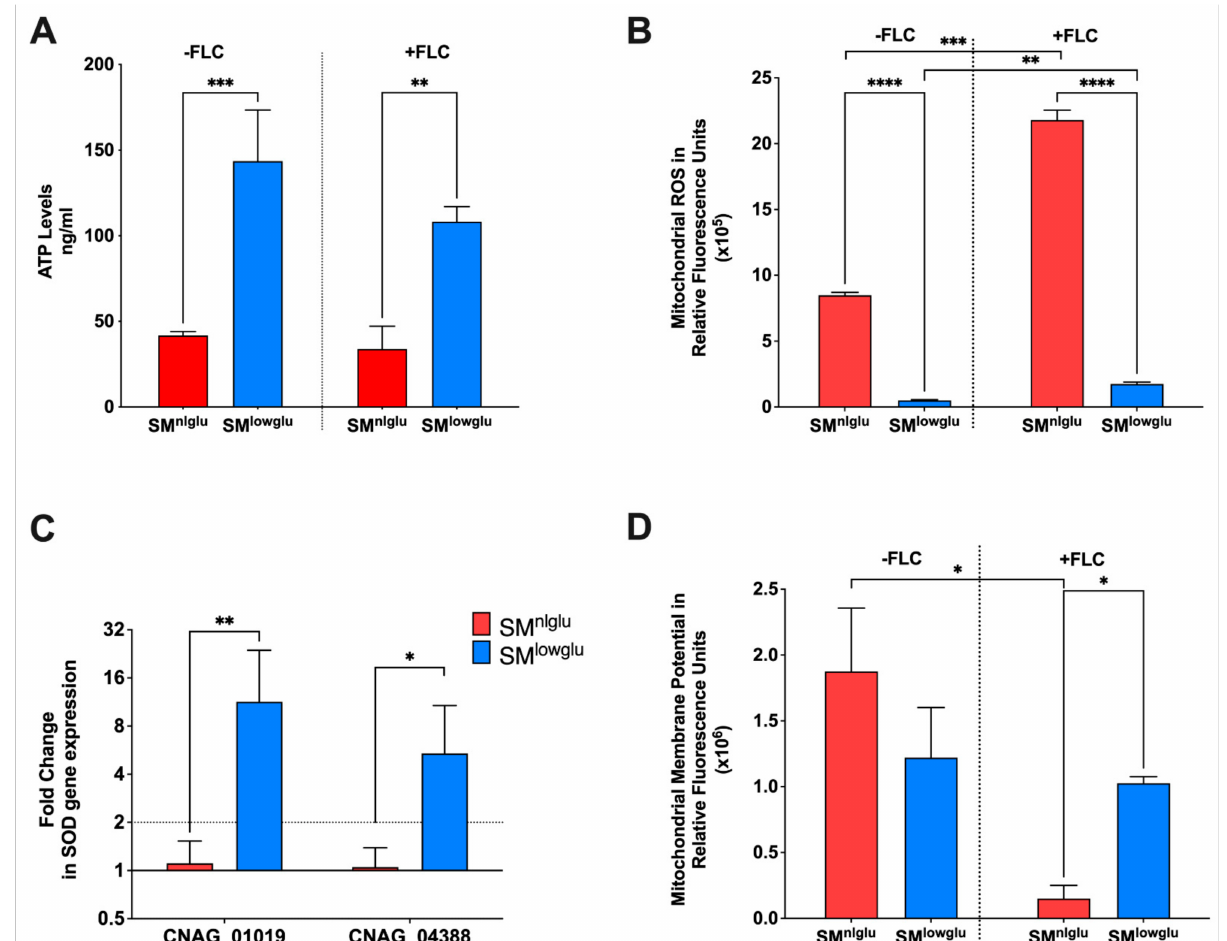
Figure 2. Effects of low glucose on mitochondrial function. ( A ) In SM lowglu media, cellular ATP levels were increased in KN99 α ; blue bar signifies cellular ATP levels in SM lowglu medium; red bar signifies cellular ATP levels in SM nlglu medium. The assay was performed in biological triplicate in the presence (+FLC) or absence ( − FLC) of 1 µ g/mL FLC. Error bars signify the standard deviation of the replicates. Student’s t -test with Welch’s correction was performed to determine the p -value (** p = 0.0013, *** p = 0.0002). ( B ) Under low glucose, mitochondrial ROS (mROS) levels were lower; blue bar signifies mROS levels in SM lowglu medium; red bar signifies mROS levels in SM nlglu medium. The assays were performed in the presence (+FLC) or absence ( − FLC) of 1 µ g/mL FLC. The assay was performed in biological triplicate. Error bars signify the standard deviation of the triplicates. Student’s t -test with Welch’s correction was performed to determine the p -value (**** p < 0.0001, *** p = 0.004, ** p = 0.0022). ( C ) Under low glucose, the expression of genes encoding superoxide dismutases (SOD) was significantly higher. the blue bar signifies gene expression under SM lowglu medium; the red bar signifies gene expression under SM nlglu medium. qPCR was used to analyze the expression of SODs in KN99 α cells grown in SM nlglu and SM lowglu media. CNAG_01019 encodes mitochondrial SOD while CNAG_04388 encodes cytoplasmic SOD. The data were normalized to the gene expression in the cells grown in SM nlglu medium. ACT1 was used as an internal control for the qPCR. The dotted lines signify two-fold up- or downregulation of the respective genes. qPCR was performed in biological triplicate and error bars signify standard deviations in the replicates. Student’s t -test with Welch’s correction was performed to determine the p -value (** p = 0.0063, * p = 0.027). ( D ) Under low glucose, mitochondrial membrane potential (MMP) was lower; blue bar signifies MMP levels in calorie restriction SM lowglu medium; red bar signifies MMP levels in normal SM nlglu medium. The assays were done in the presence (+FLC) or absence ( − FLC) of 1 µ g/mL of FLC. The assay was performed in biological triplicate. Error bars signify the standard deviation of the triplicate values. Student’s t -test with Welch’s correction was performed to determine the p -value (* p <